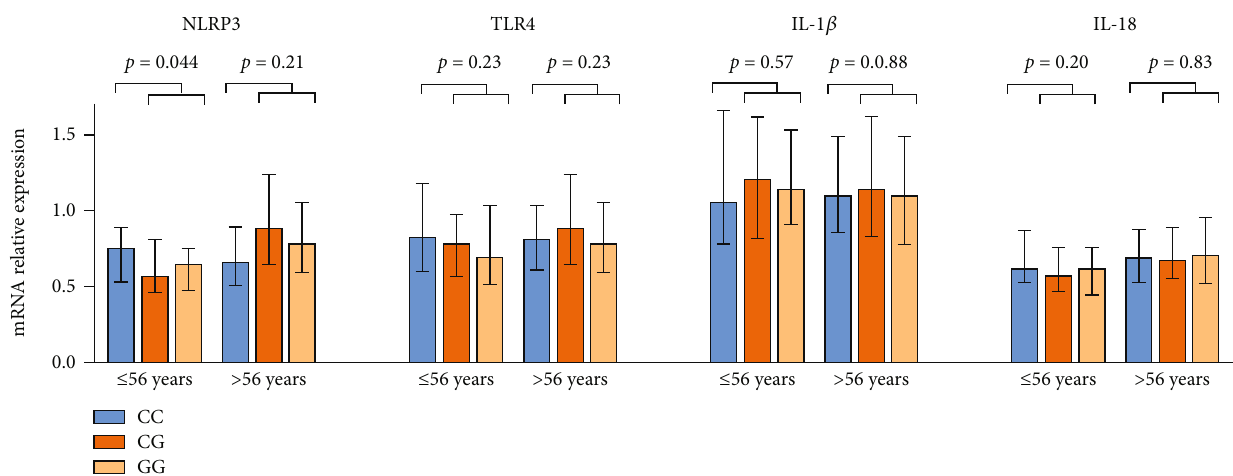
Figure 2: Change in gene expression (mRNA levels) of NLRP3, TLR4, IL-1 β , and IL-18 according to NLRP3 genotypes. Blue, orange, and pale orange columns represent homozygous wild type (CC), heterozygous (CG), and homozygous of the gene variant (GG), respectively. Results are dichotomized according to age at the 25 percentile level (56 years). p values represent di ff erence in gene expression of each marker between the CC genotype and the G-allele (CG/GG combined) (Mann – Whitney test). Table 6: Circulating levels of markers as related to NLRP3 genotypes in the total population.